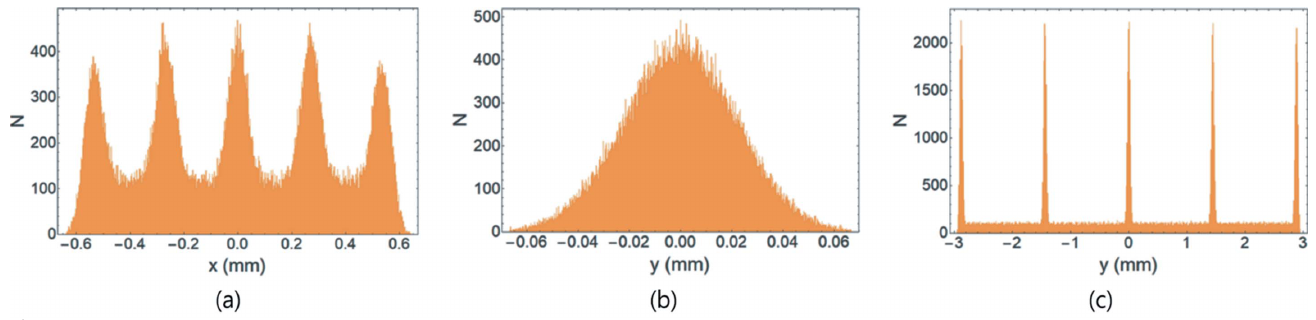
Figure 4 Density distribution on the x and y axis for the beam distribution shown in Fig. 3. ( a ) Density on the x axis when the TDC is on or off, ( b ) density on the y axis when the TDC is off, and ( c ) density on the y axis when the TDC is